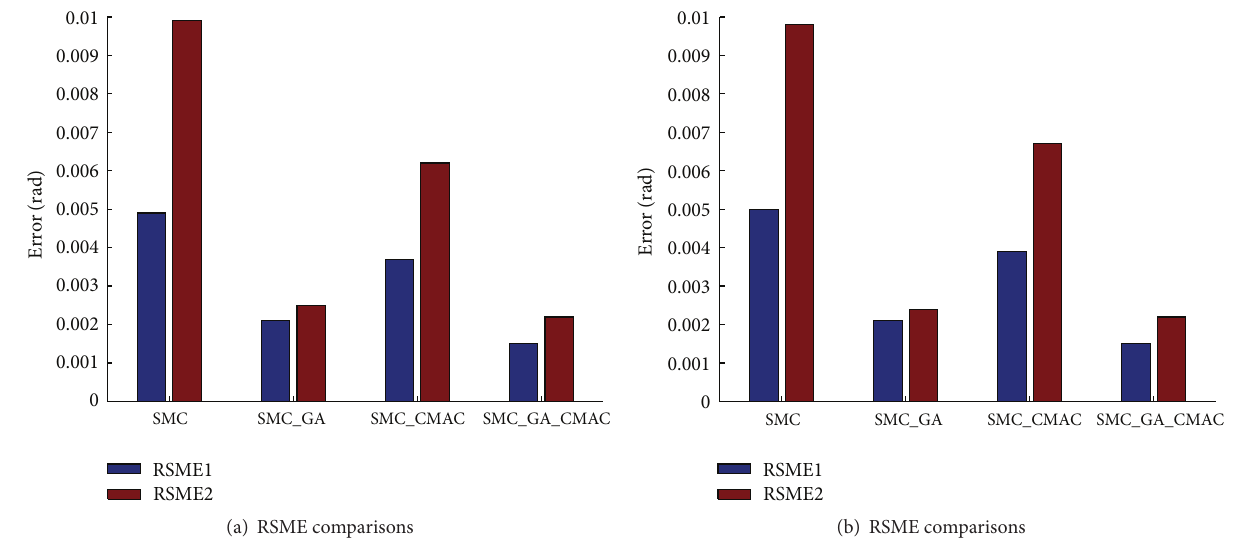
Figure 10: RSME comparisons in Case One (without disturbance) and Case Two (with bounded disturbance), respectively. RSME1 is for the hip joint while RSME2 is for the knee joint.